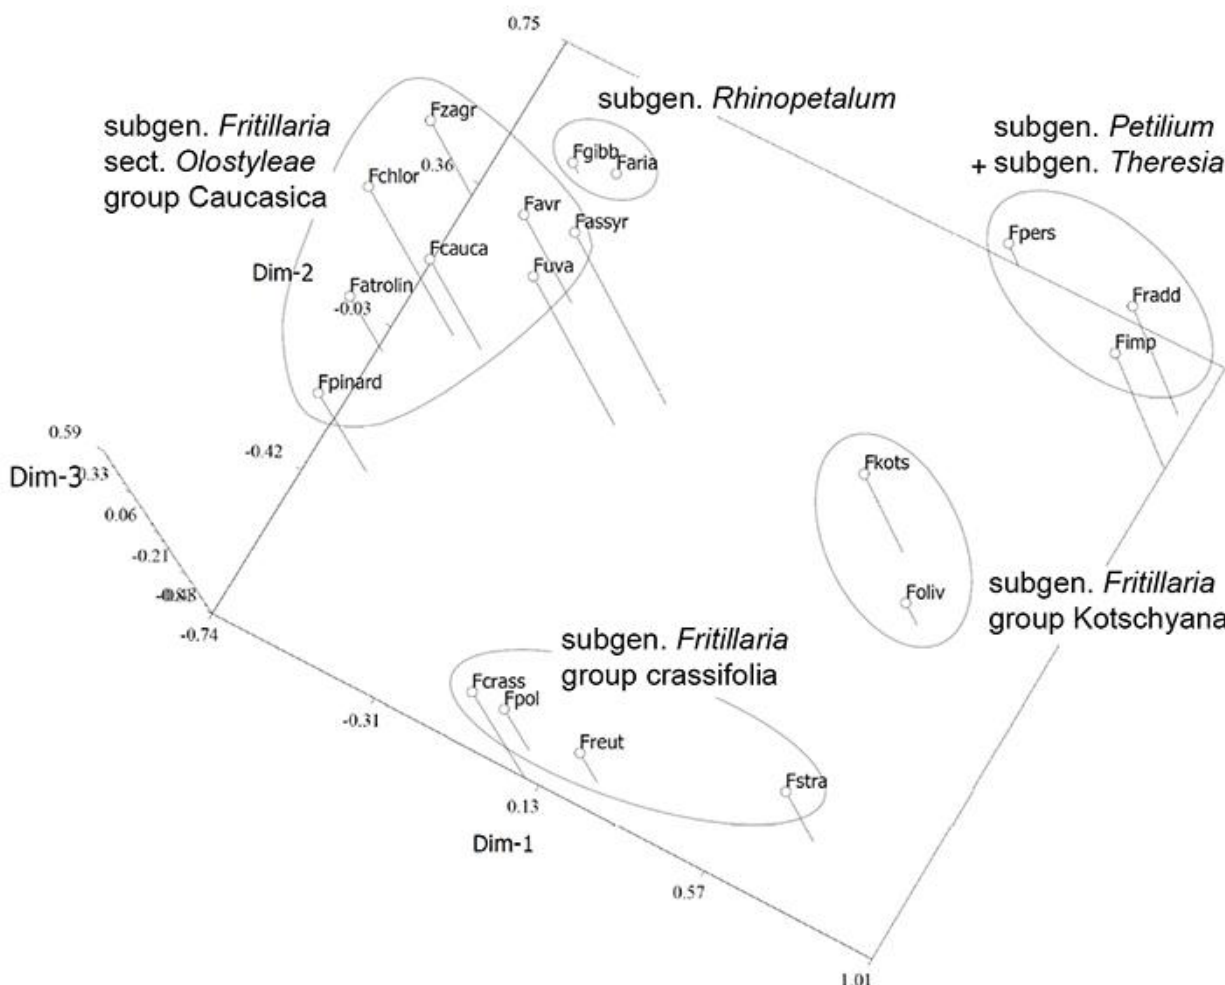
Fig. 2. PCO diagram for analysis of morphological characters. Abbreviations: Fzagr: F. zagrica, Fchlor: F. chlorantha, Favr: F. avromanica, Fassyr: F. assyriaca, Fuva: F. uva-vulpis, Fcauca: F. caucasica, Fatrolin: F. atrolineata, Fpinard: F. pinardii, Fgibb: F. gibbosa, Faria: F. ariana, Fpers: F. persica, Fradd: F. raddeana, Fimp: F. imperialis, Fkots: F. kotschyana, Foliv: F. olivieri, Fcrass: F. crassifolia subspecies kurdica, Fpol: F. poluninii, Freut: F. reuteri, Fstra: F. straussii. differences 2, Fig. 3). In